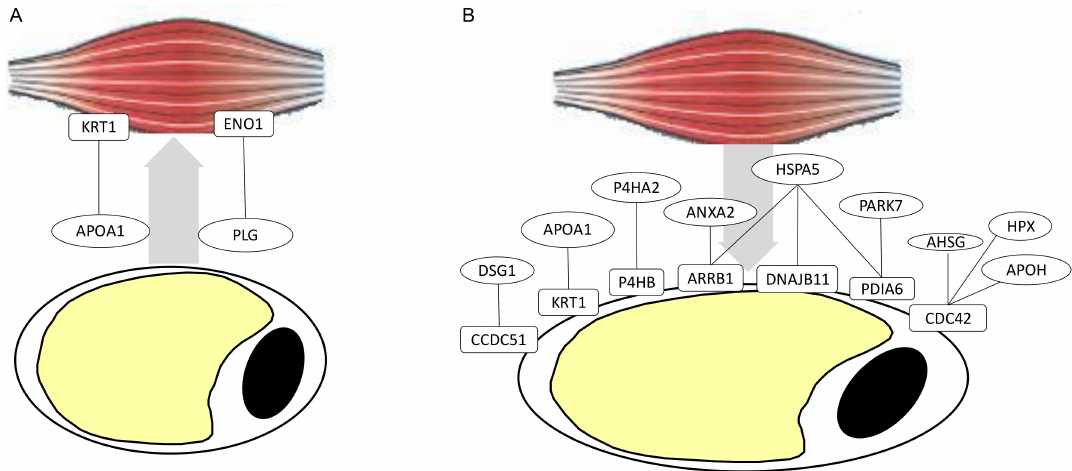
Figure 4. Network of interacting proteins between the proteins potentially secreted by ( A ) Adipose and the muscular cell surface proteins, or ( B ) between the muscle and adipose cell surface proteins. Protein–protein interactions (PPI) between the proteins were identified thank to the PPIs referenced within UniProt, IntAct, and BioGrid databases, which were schematized between an adipocyte and muscle